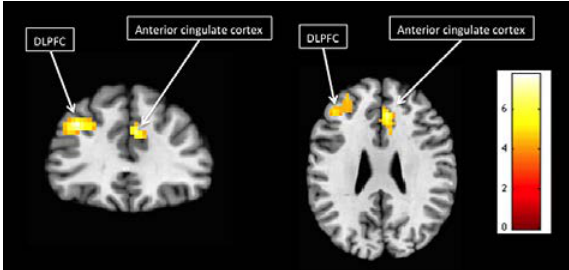
Figure 3: Statistical parametric maps of effect of mirror in children with hemi- paresis, bimanual experiment observed in the dorsolateral prefrontal cortex (DLPFC; affected hemisphere) and anterior cingulate cortex (unaffected